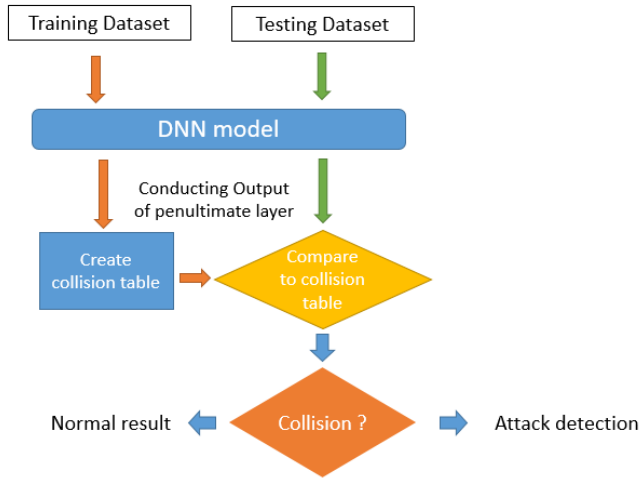
Figure 5. Flowchart showing detection of target attacks in IDA algorithm.